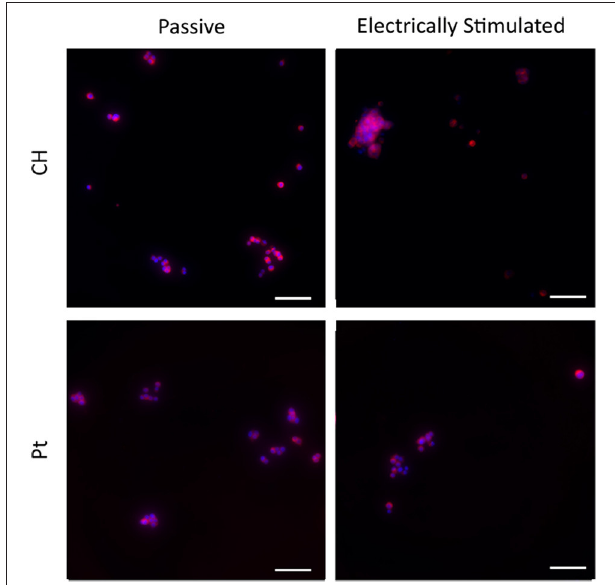
FIGURE 9 | Magnified immunofluorescence images of PC12 cultures on passive and electrically stimulated Pt and CH substrates. Nuclei were stained with Hoechst 33,342 (blue) and PC12 cell bodies and neurites stained with anti- β III-tubulin (red). Scale bars = 150 µ m.